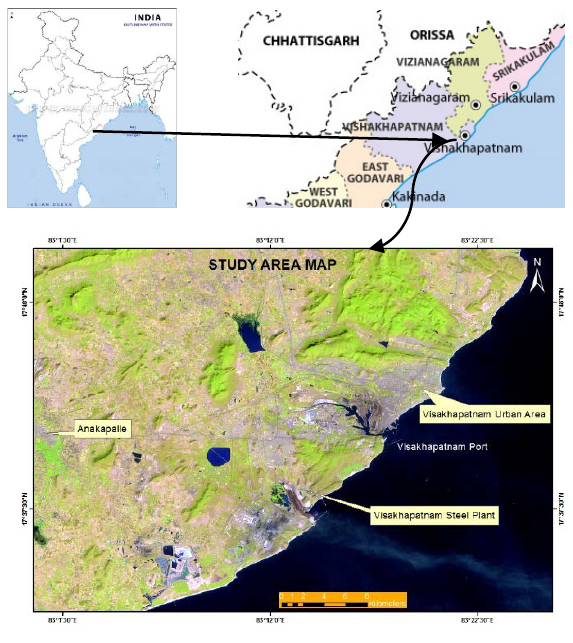
Figure 1. Study Area